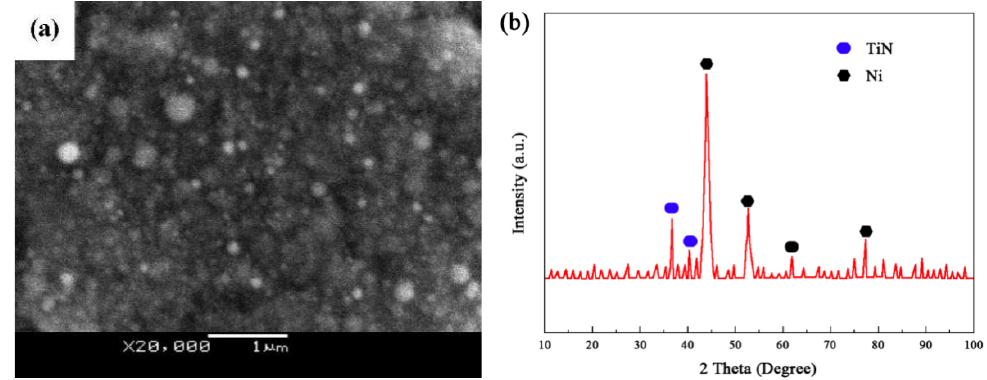
Figure 5. SEM image ( a ) and XRD pattern ( b ) of the Ni-TiN nanoplating.